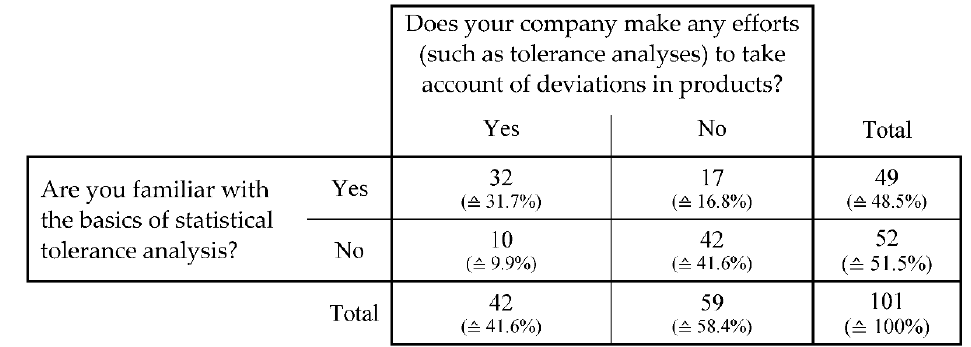
Figure 5. Cross-evaluation of the response of 101 participants to the (single-choice) question: “Are you familiar with the basics of statistical tolerance analysis?” and the (single-choice) question: “Does your company make any efforts (such as tolerance analyses) to take account of deviations in products?”.